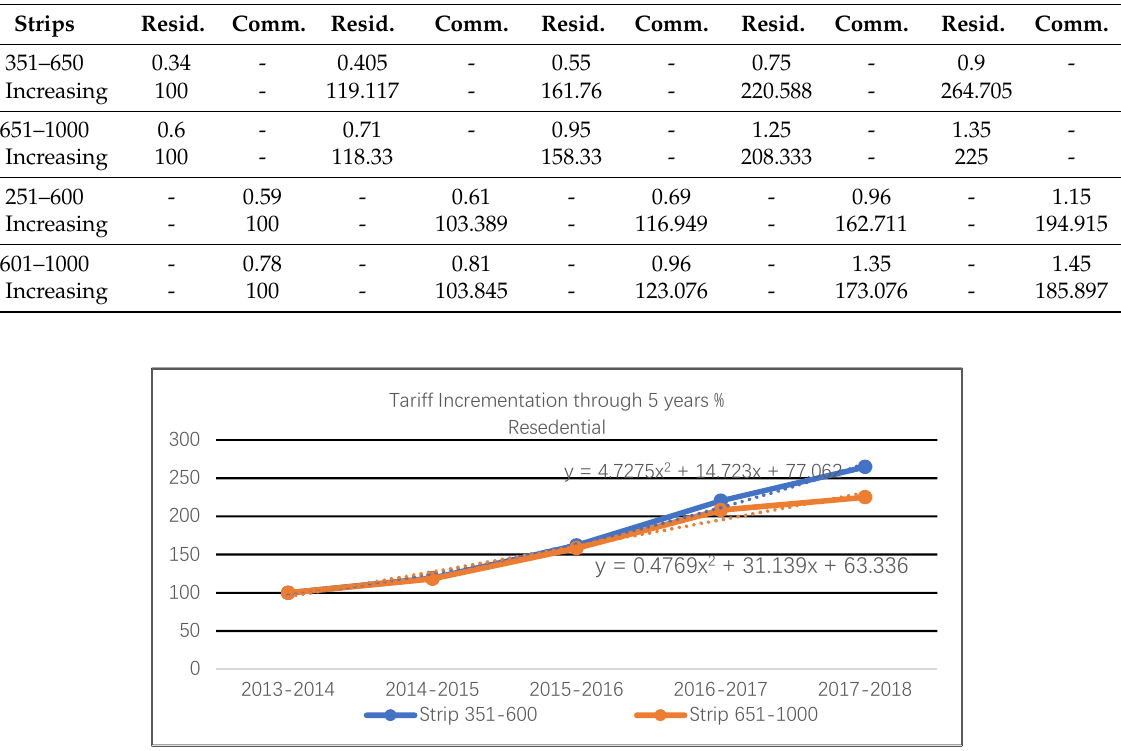
Figure 8. Percentages incrementations in case of residential loads.